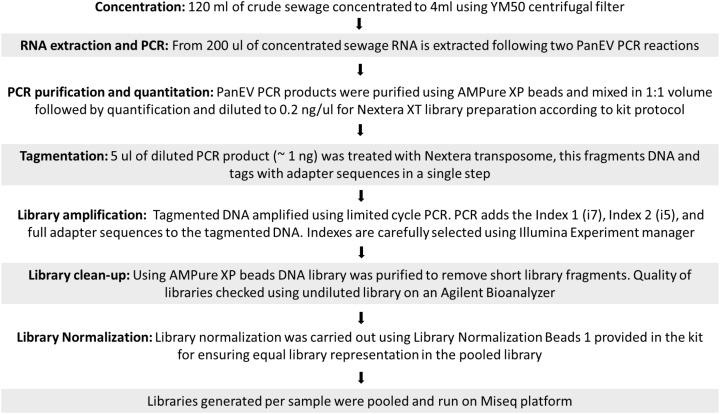
Flowchart of sequence library preparation.